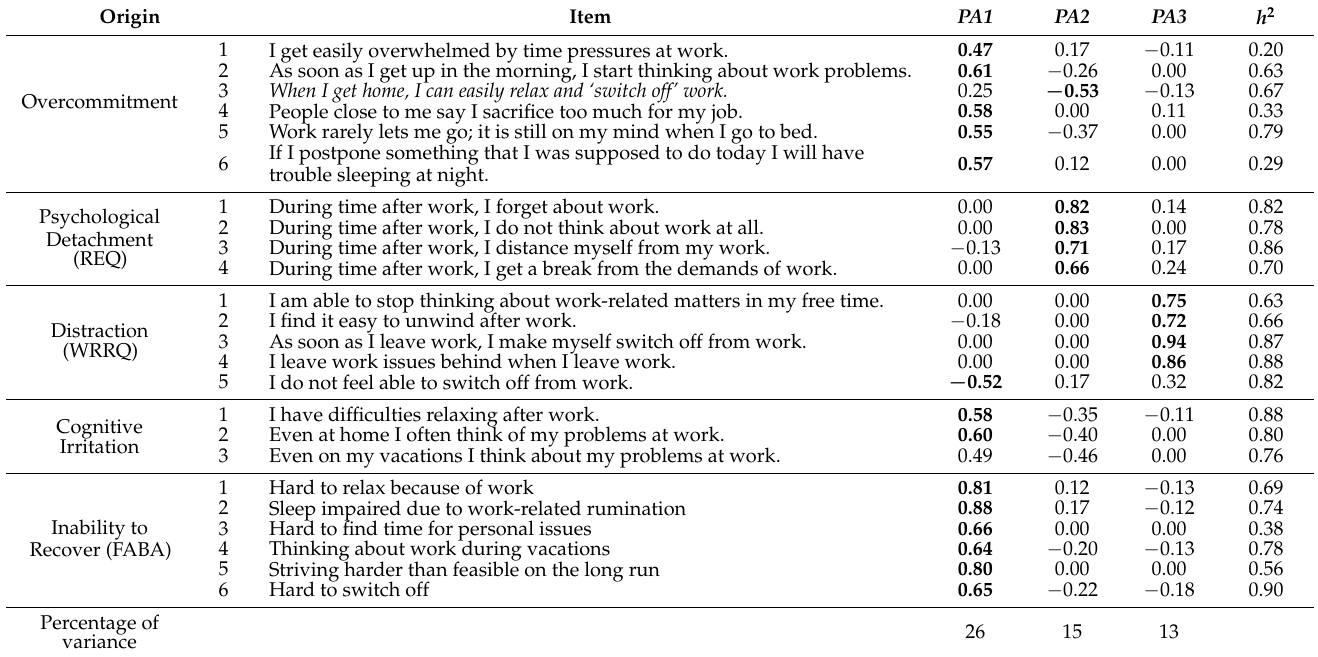
Table 3. Results of the Exploratory Factor Analyses in Sample